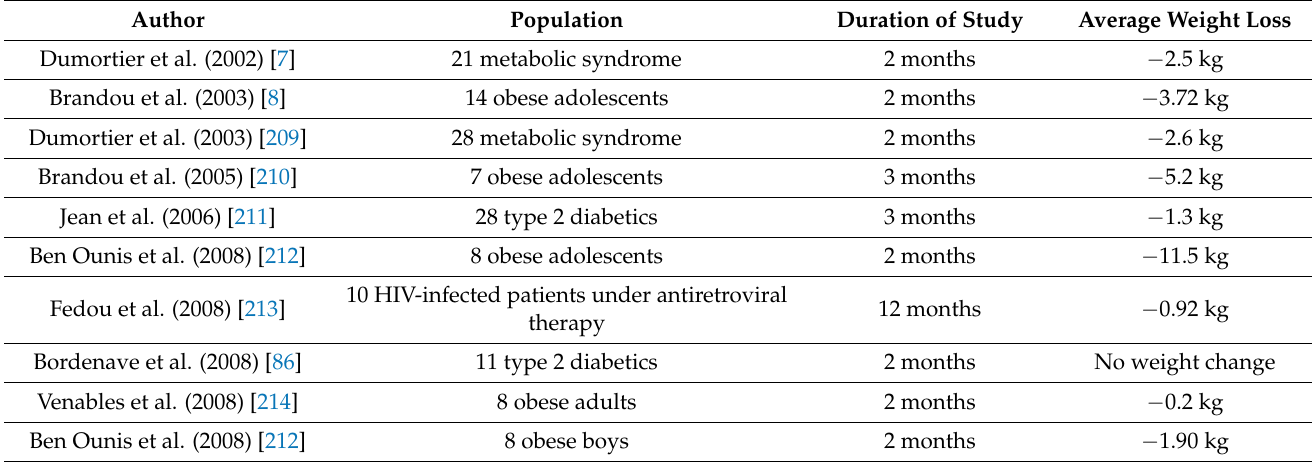
Table 2. Studies investigating the effect of LIPOXmax training in overweight. The studies on LIPOXmax training after sleeve gastrectomy are not in this table and are discussed in the text